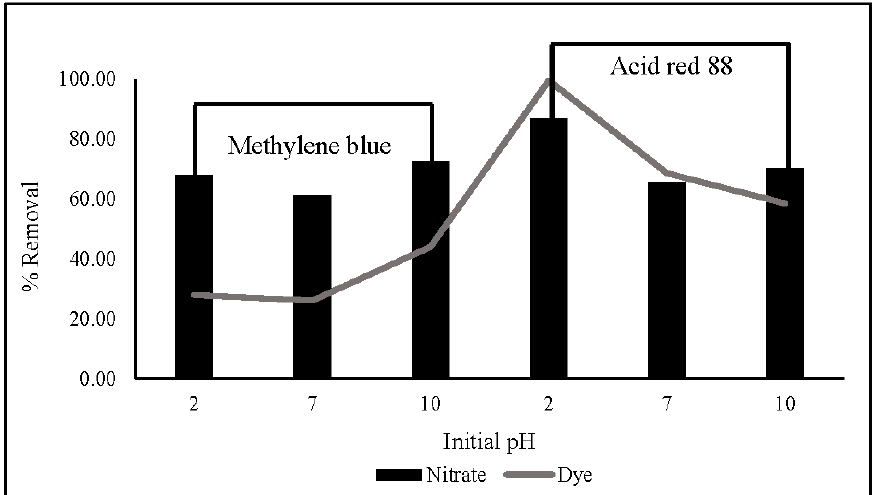
Figure 10. Effect of dyes (methylene blue and acid red 88) on nitrate and dye removal in different initial pH. (10 mg of ZLCH-Fe; initial NO 3 : 100 mg/L; initial dye: 25 mg/L; contact time: 5 min).